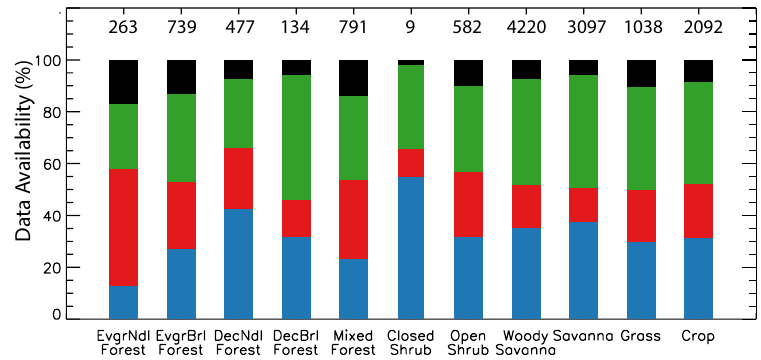
Figure 2. Data availability in the 2008 plume dataset determined per biome. Bars represent percentage of individual pixels with both stereo-height and AOD retrievals (blue), percentage with height but missing AOD retrievals (red), percentage with AOD but missingstereo-height retrievals (green) and percentage with missing both stereo-height and AOD retrievals (black). The number of plumes included in each distribution is given above the bar plots.